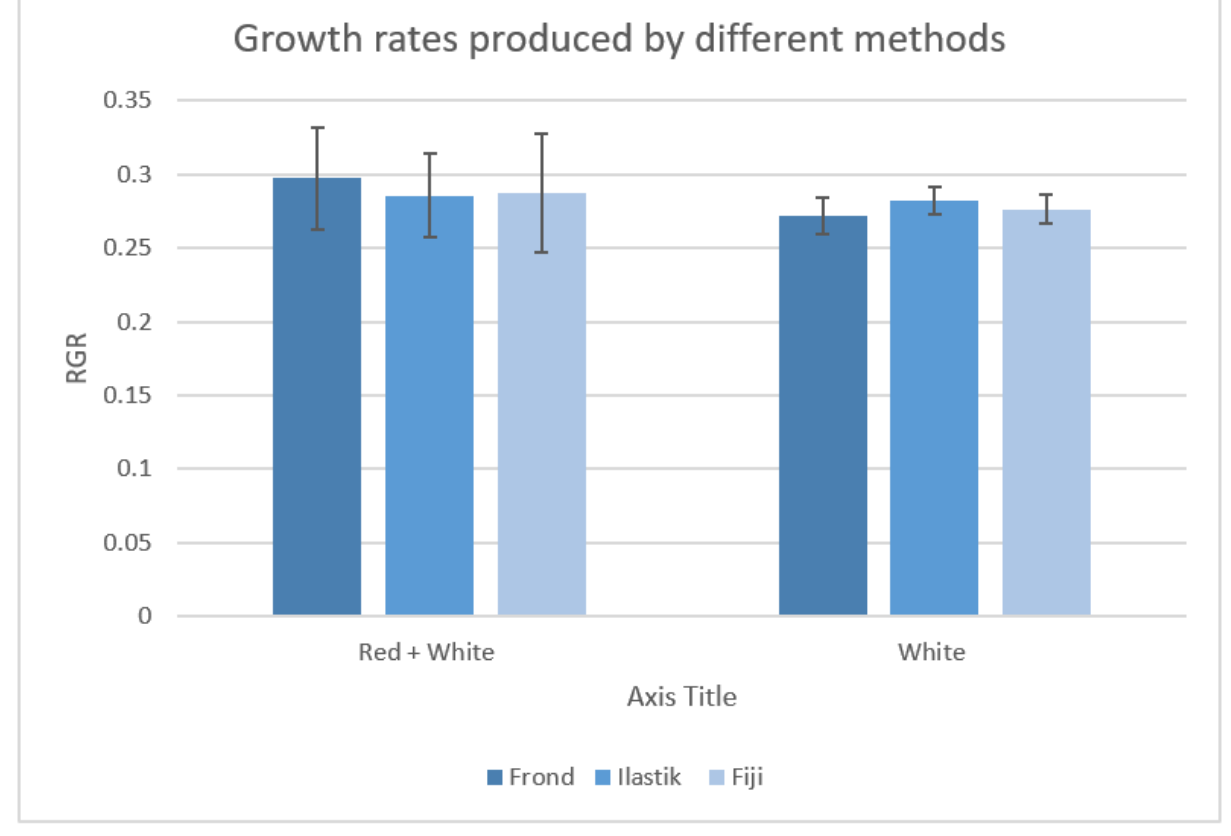
Figure 1. Graph compares RGR calculated with three methods (frond number, ilastik ® and Fiji) for the two experiment setups (red-light treatment and control).